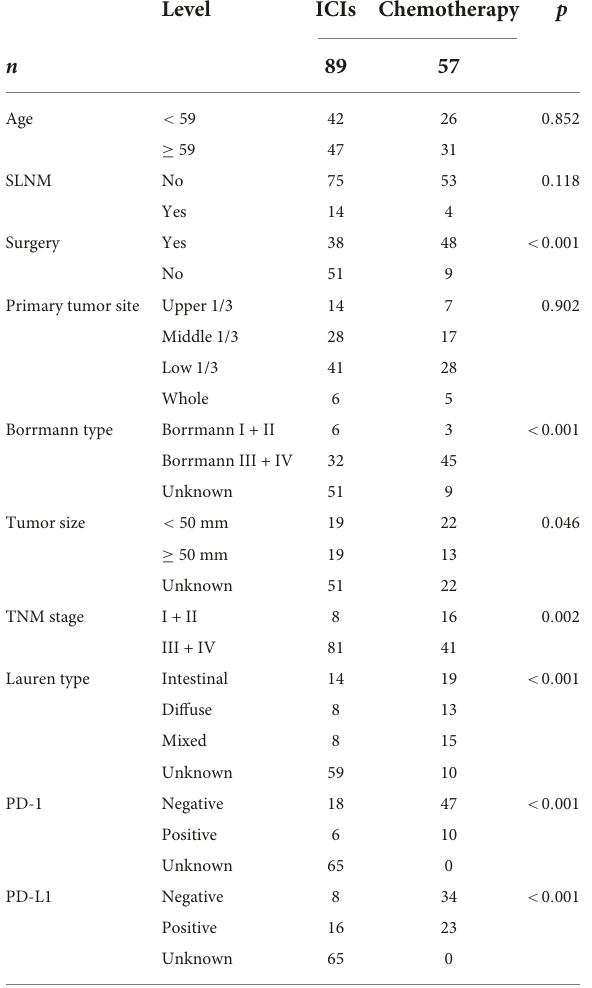
TABLE 4 The clinical information for the treatment. In the low PALB group, there were 29 cases in the low PNI group and 43 cases in the high PNI group. The MST for PFS Level ICIs Chemotherapy p in the low PNI group and high PNI group was 10.40 months vs. 33.07 months, respectively, while the MST for OS in the two groups was 17.00 months vs. 41.63 months. Low PNI group’s patients had poorer PFS and OS than patients in the high PNI group in this study (HR = 2.191, 95% CI: 1.150–4.175, p = 0.015 0 . 118 and HR = 2.429, 95% CI: 1.268–4.653, p = 0.006) ( Figures 6A,B ). In the high PALB group, there were 12 cases in the low PNI group and 62 cases in the high PNI group. The MST for PFS in the low PNI group and high PNI group was not reached vs. 28.37 months, while the MST for OS in the two groups was both not reached. There was no significant difference for PFS and